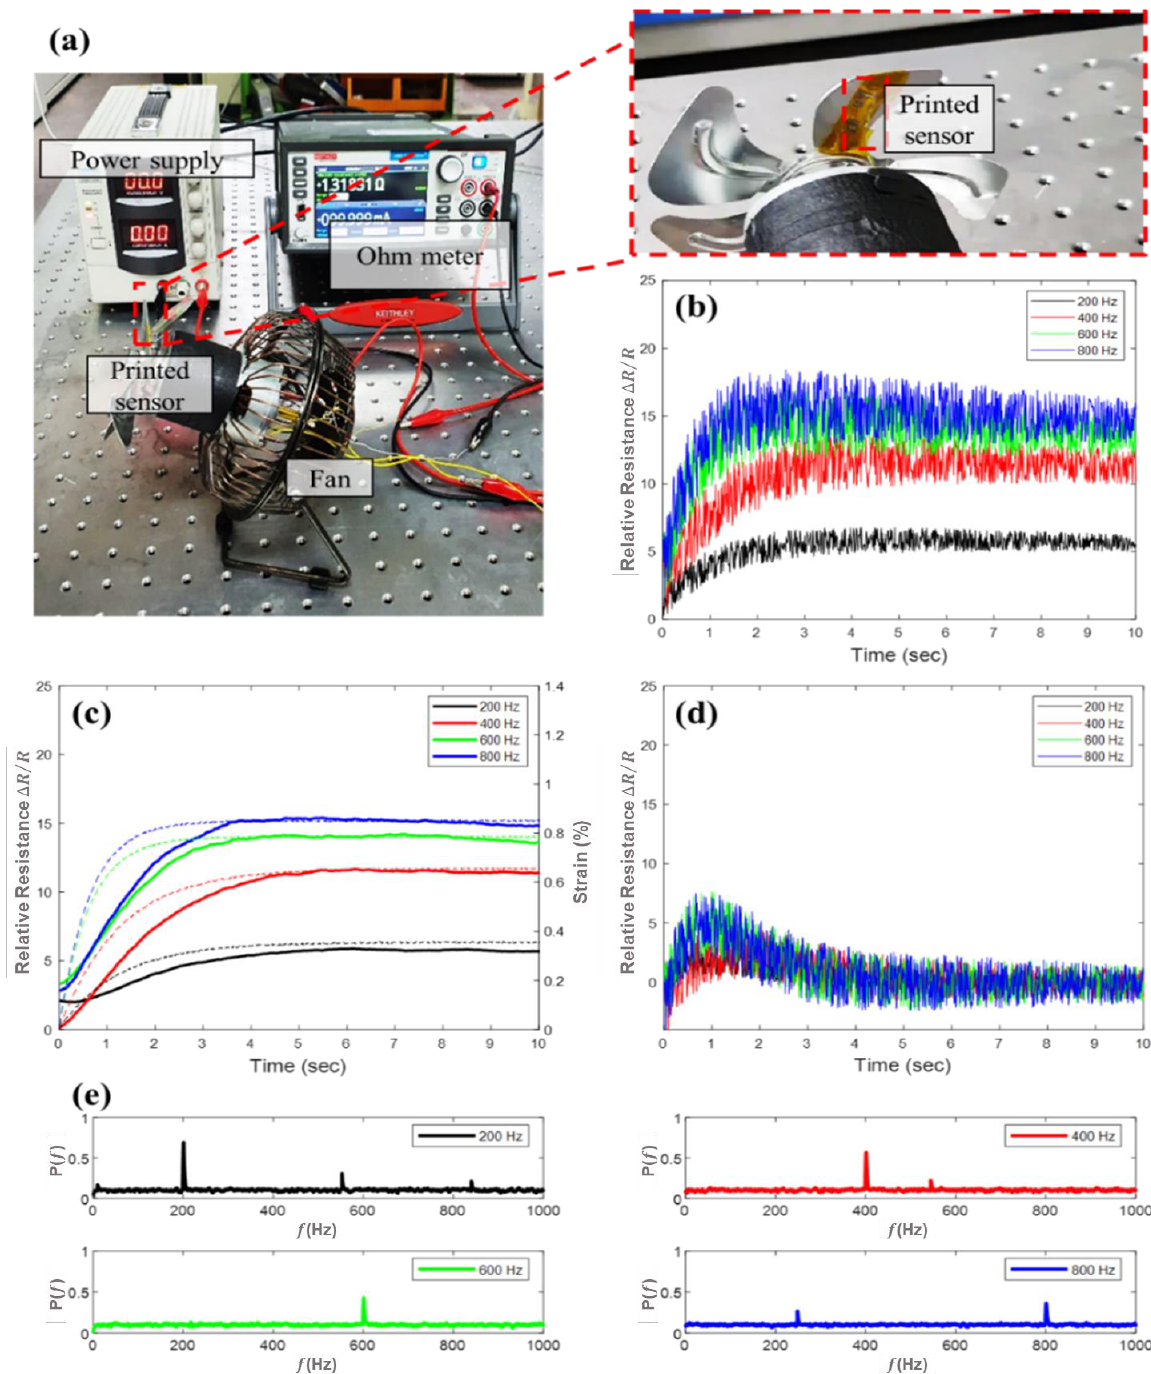
Figure 3. ( a ) Photograph of the experimental setup for strain and vibration measurement of the fan blade ( b ) Measured resistance according to rotor frequency. ( c ) Estimated strain from the printed sensor using the Kalman filter (solid line) and measured strain from the commercial strain gauge (dotted line) ( d ) Estimated vibration obtained by subtracting the estimated strain from the measured resistance. ( e ) Fast Fourier transform (FFT) results of estimated vibration.